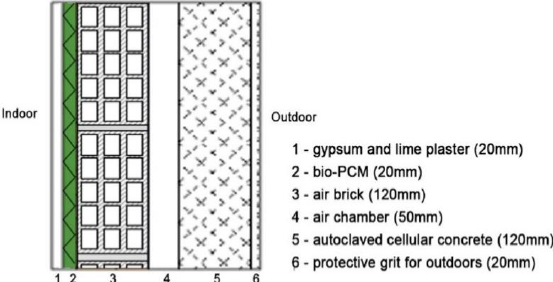
Figure 12. Wall stratigraphy with the PCM-layer.